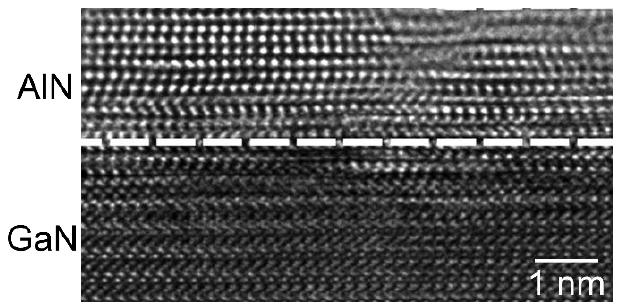
Figure 3. High resolution TEM image of the AlN/GaN interface region.